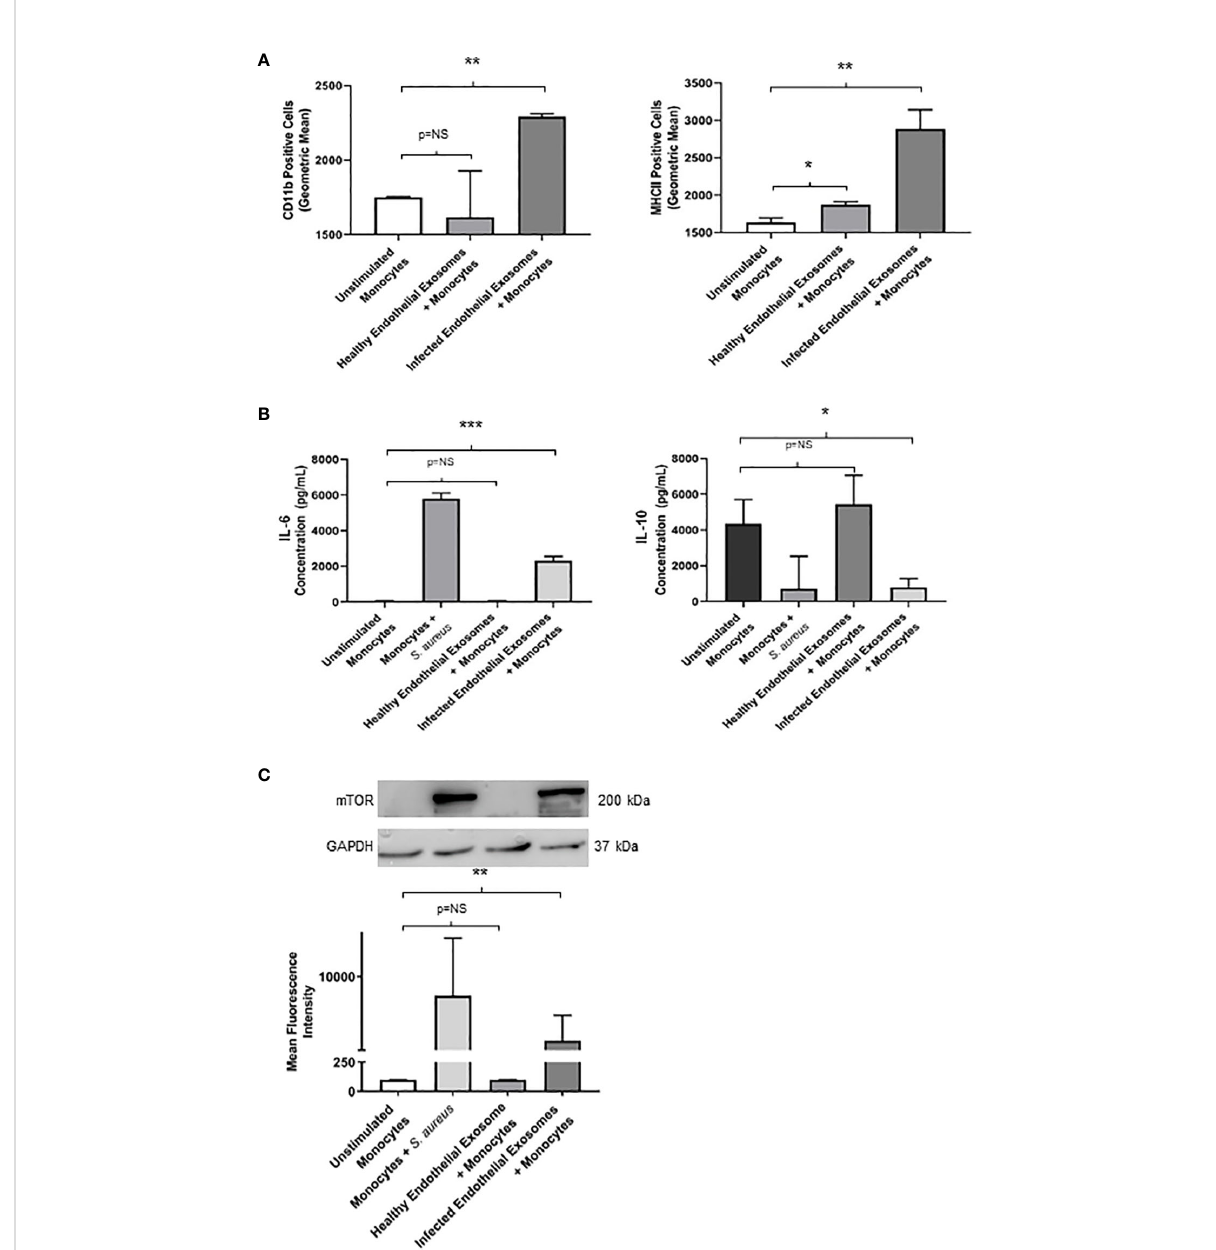
FIGURE 4 Infected endothelial exosomes promote a proin fl ammatory phenotype in monocytes following uptake (A) Expression of proin fl ammatory markers CD11b and MHCII were analysed on the surface of monocytes by fl ow cytometry after 24 hours. Data is represented as bar graphs using geometric mean taken from baseline negative control. Signi fi cant increases in CD11b and MHCII levels were observed in monocytes that had taken up infected exosomes. (B) Basal levels of IL-6 (35 pg/mL) and IL-10 (4300 pg/mL) were obtained in unstimulated THP-1 monocytes by ELISA. Direct S. aureus infection had the greatest in fl uence on IL-6 and IL-10 production from monocytes. Healthy endothelial exosomes had no effect on cytokine expression compared to unstimulated monocytes. Exosomes from S. aureus infected endothelial cells induced a signi fi cant increase in IL-6 and a negatively correlating decrease in IL-10 production in monocytes. (C) Western blot and densitometry analyses of mTOR levels (200 kDa) in monocytes following delivery of healthy or infected exosomes after 24 hours. GAPDH (37 kDa) used as loading control. Positive control (monocytes + S. aureus ) showed greatest mTOR protein expression. Signi fi cantly elevated mTOR levels were observed in monocytes following uptake of S. aureus infected endothelial exosomes. Data is represented as mean ± SEM (n=3 CD11b; n=4 MHCII; *p<0.05; **p<0.01, ***p<0.001). NS, not signi fi